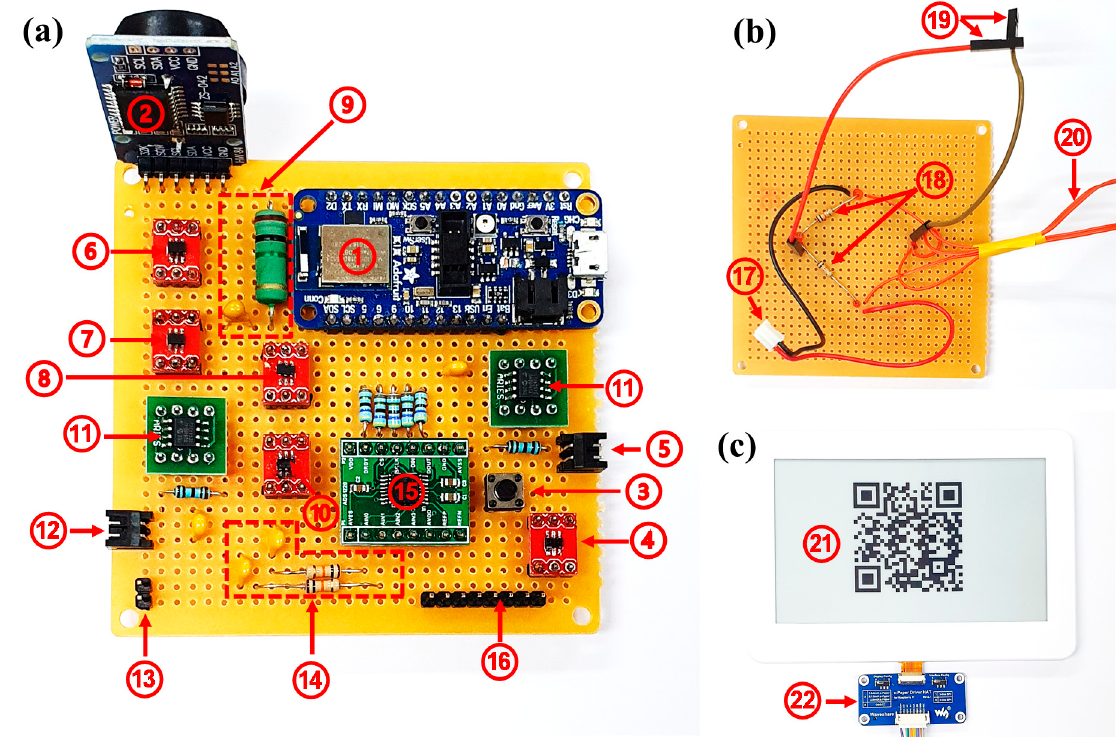
Figure 6. SSVM prototype: ( a ) triggering devices, power management devices, ADC, MCU, and connectors; ( b ) strain-to- voltage conversion; ( c ) visualization.